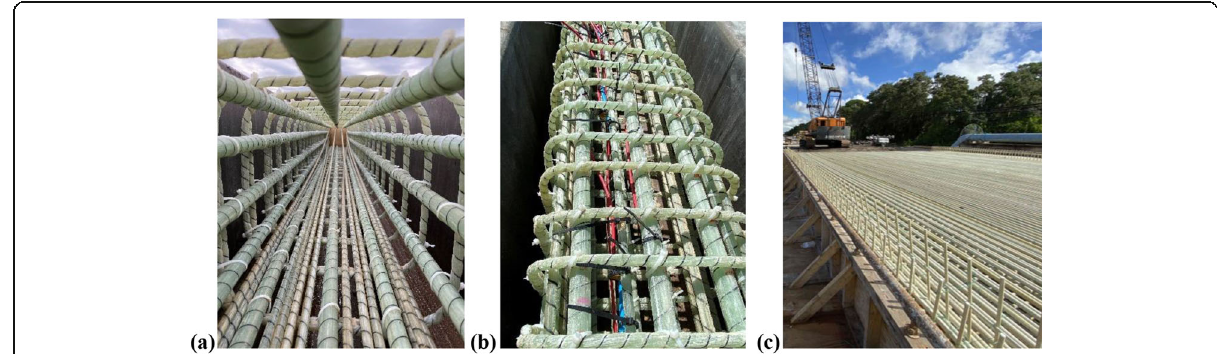
Fig. 4 Typical examples of new GFRP-RC/PC construction: a Soldier pile fabrication before tensioning, and b after tensioning #4 bar strands [68]; c CIP flat-slab bridge conservative reinforcing